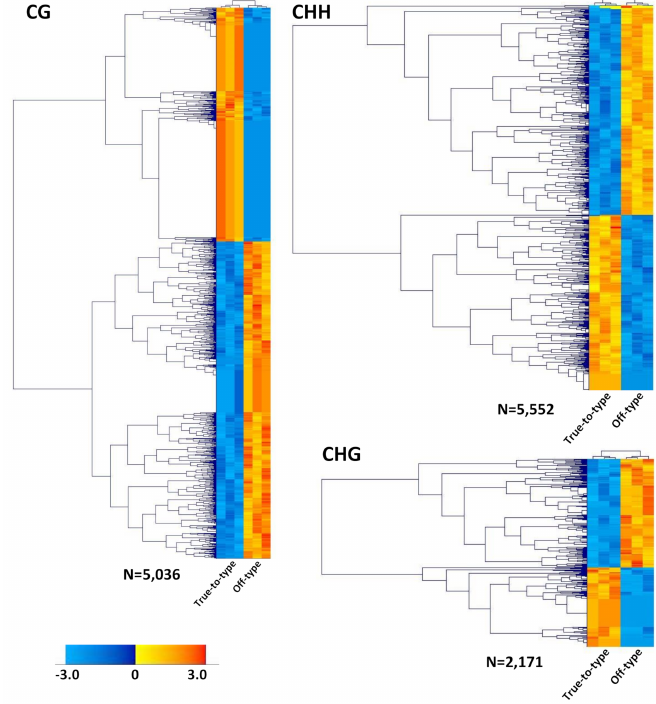
Figure 2. Heatmaps of CG, CHH, and CHG di ff erentially methylated loci. Normalized loci, expressed as log2 (Fold Change) of the relative count numbers, from three replicates of true-to-type and o ff -type samples, were clustered using hierarchical average linkage clustering and Euclidean distances ( p ≤ 0.05). Columns and rows represent samples assayed (true-to-type on the left, o ff -type on the right) and di ff erentially methylated loci (DML), respectively. For each methylation context two main clusters are distinguishable, showing an opposite methylation trend between true-to-type and o ff -type phenotypes. Color-code of di ff erential methylation state is reported on the bottom left, resulting in values between − 3 ( = maximum level of methylation; blue) and 3 ( = no methylation;